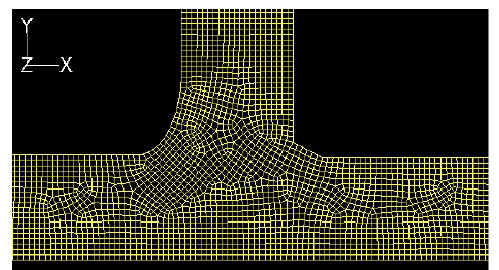
Figure 8. Computational T-junction mesh cross-section close-up (5.67 µ m paved) The full computational volume for the microfluidic T-